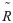
Percentage of the change in the WSA when disk size of collaborating nodes R˜ is varied.